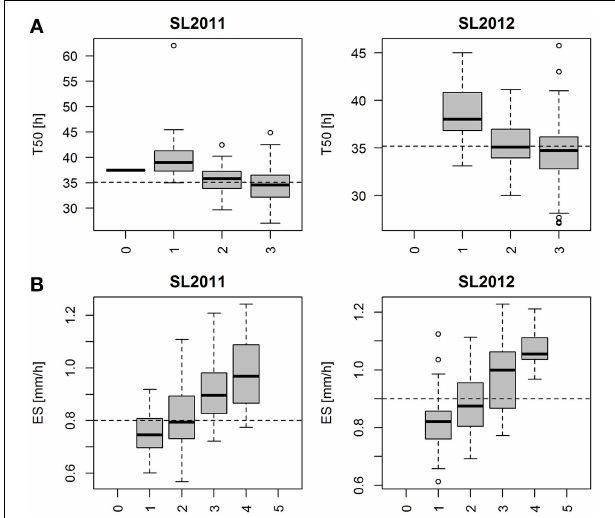
FIGURE 9 | (A) Boxplot representing the phenotypic distribution for T50 (Time to reach 50% of germination) in two different seed lots, produced in 2011 (SL2011) and 2012 (SL2012). Each whisker represents a bulk of genotypes exhibiting no favorable haplotype (0), one favorable haplotype (1), two favorable haplotypes (2) and three favorable haplotypes (3) regarding the three associated regions on chromosome A9, C6 and C8. Population means were indicated as dashed lines. (B) Boxplot representing the phenotypic distribution for ES (Elongation speed of the radicle) in two different seed lots, produced in 2011 (SL2011) and 2012 (SL2012). Each whisker represents a bulk of genotypes exhibiting no favorable haplotype (0), one favorable haplotype (1), two favorable haplotypes (2) three favorable haplotypes (3), four favorable haplotypes (4) and five favorable haplotypes (5) regarding the five disclosed associated regions on chromosome A9, A6, A10, C2, and C6. Population means were indicated as dashed